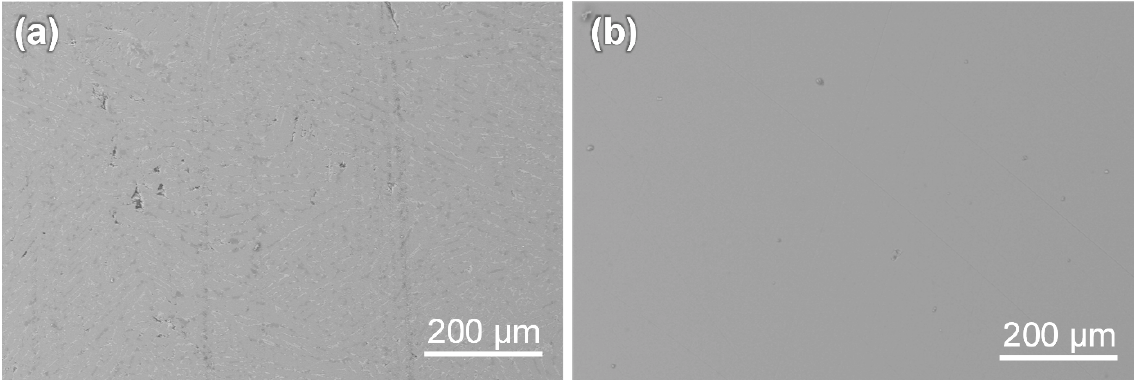
Figure 6. Morphologies of slag samples at 1550 °C: ( a ) Slag B1, R = 2, w (TiO 2 ) = 5%; ( b ) Slag A1, R = 6, w (TiO 2 ) = 0%.